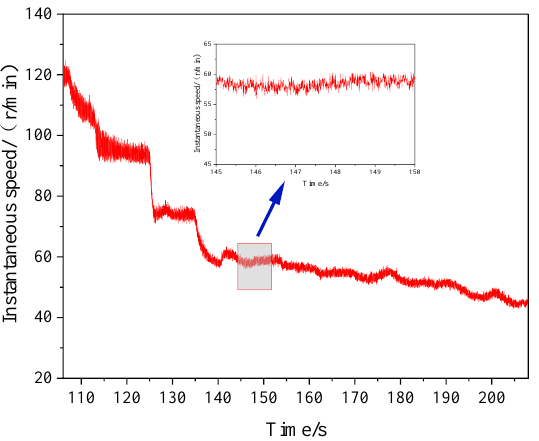
Figure 9. Instantaneous rotational speed of the intermediate shaft after smoothing. Record the number of black stripes on the coding belt installed on the shafting, that were the total number of pulses, n. According to the calculation formula of average angu- lar velocity: In Formula (15), θ 0 is the angle between two pulses on the coding blet, θ 0 = 2 π / n ; where t is the time interval between two adjacent pulses passing through the laser sensor, ∆ t = t − t . According to Formula (15), calculate the average speed of the intermediate shaft. The variation relationship of the average speed with time is shown in Figure 10. The speed fluctuation of the shafting can be obtained by subtracting the average speed from the fil- tered instantaneous speed. Filter and integrate the rotational speed fluctuation signal, and slice the calculation results to obtain the displacement amplitudes of different harmonic torsion angles of the measured shafting, as shown in Figure 11: